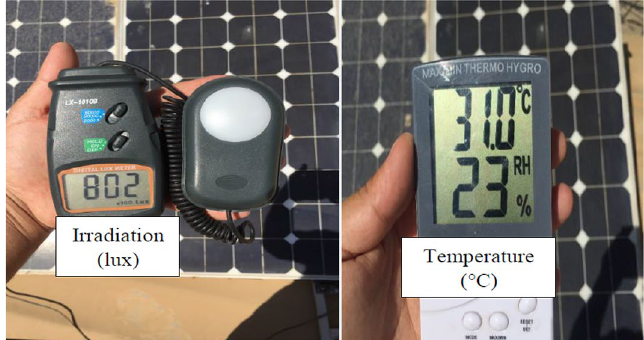
Figure 16. Measurements of irradiance and temperature for the proposed PV